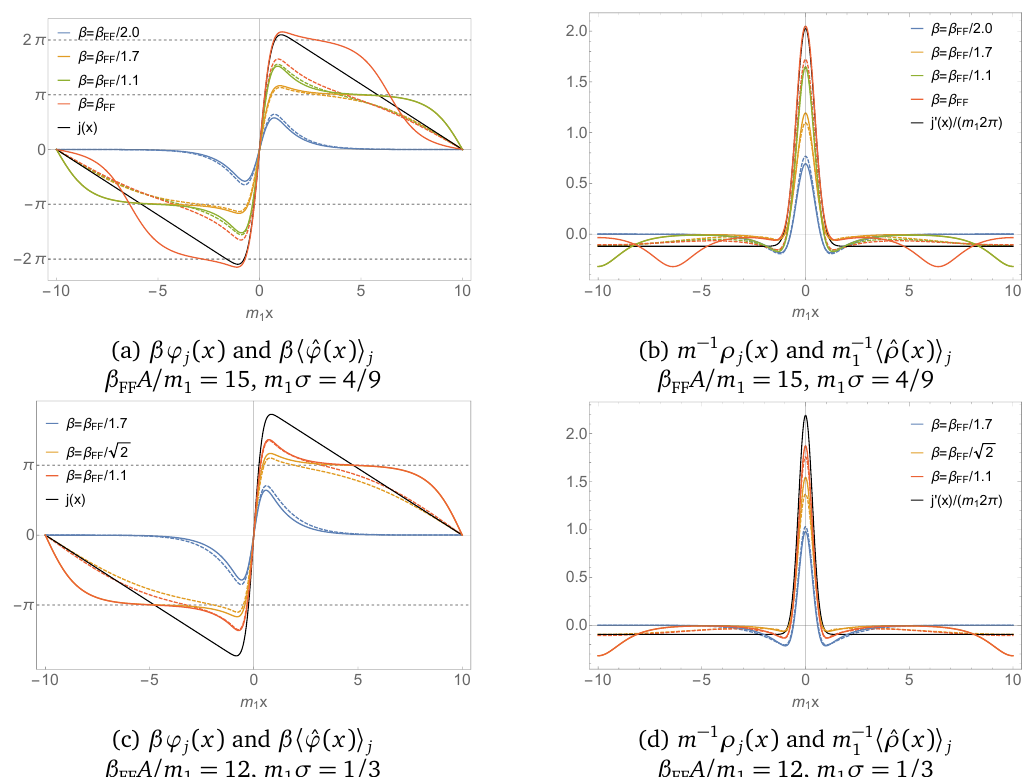
Figure B.2: Comparing quantum and classical profiles for different couplings β and for two different external field profiles corresponding to different choices of their σ , as indicated in the corres- A / m amplitude paramater β and width parameter m FF 1 1 ponding captions. Left panel : The QFT expectation values 〈 β ˆ ϕ ( x ) 〉 (dashed lines) and the classical j ( x ) (continuous lowest energy configurations βϕ j